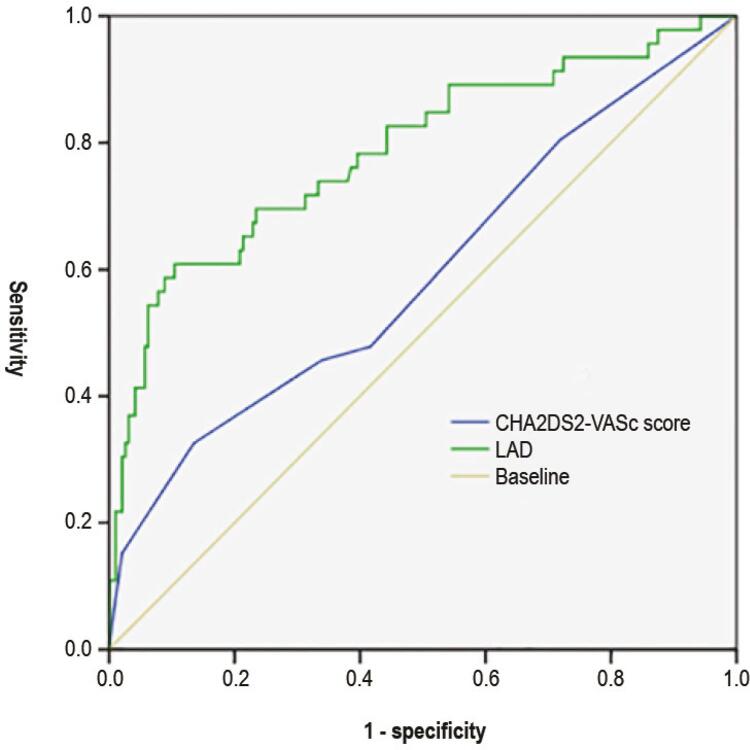
– The ROC curve analysis results showed that when the CHA2DS2-VASc score was used to predict left atrial/left atrial appendage thrombosis, the area under the curve was 0.593 (95% CI: 0.495–0.690). When the CHA2DS2-VASc score was ≥3, sensitivity and specificity were 86.5% and 32.6%, respectively. When LAD was used to predict left atrial/left atrial appendage thrombosis, the area under the curve was 0.786 (95% CI: 0.704–0.868). When LAD was >44.17 mm, sensitivity and specificity were 89.6% and 60.9%, respectively.